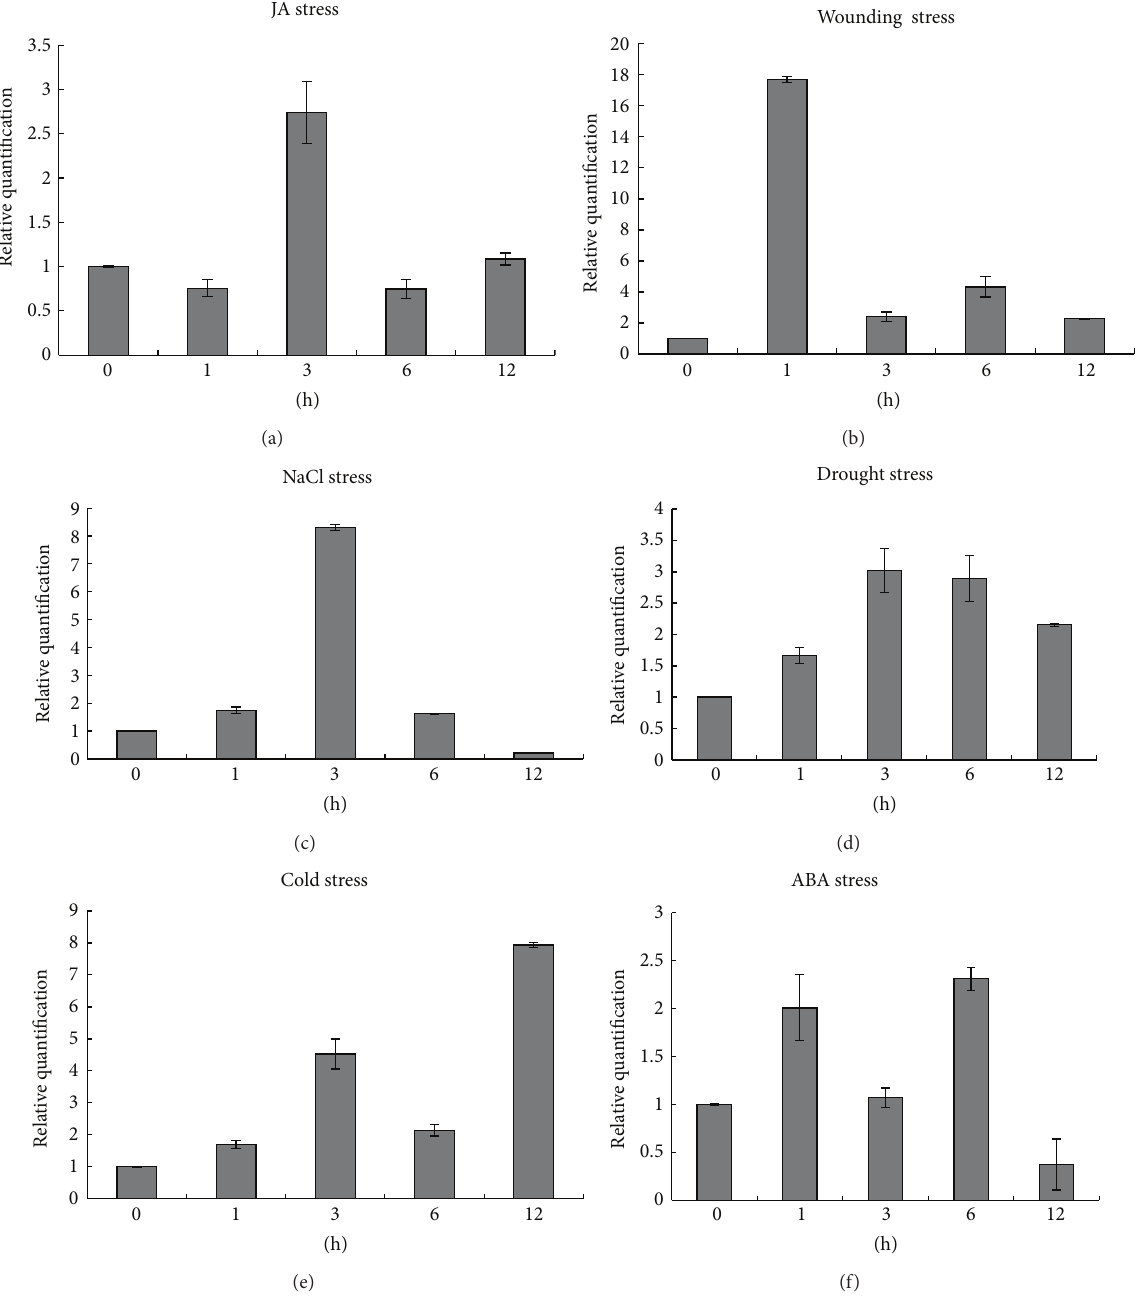
Figure 4: Expression of GmNAC5 in soybean seedlings under various stresses. The soybean seedlings were stressed with 100 𝜇 M JA (a), wounding (b), 200mM NaCl (c), drought (d), 4 ∘ C (e), and 100 𝜇 M ABA